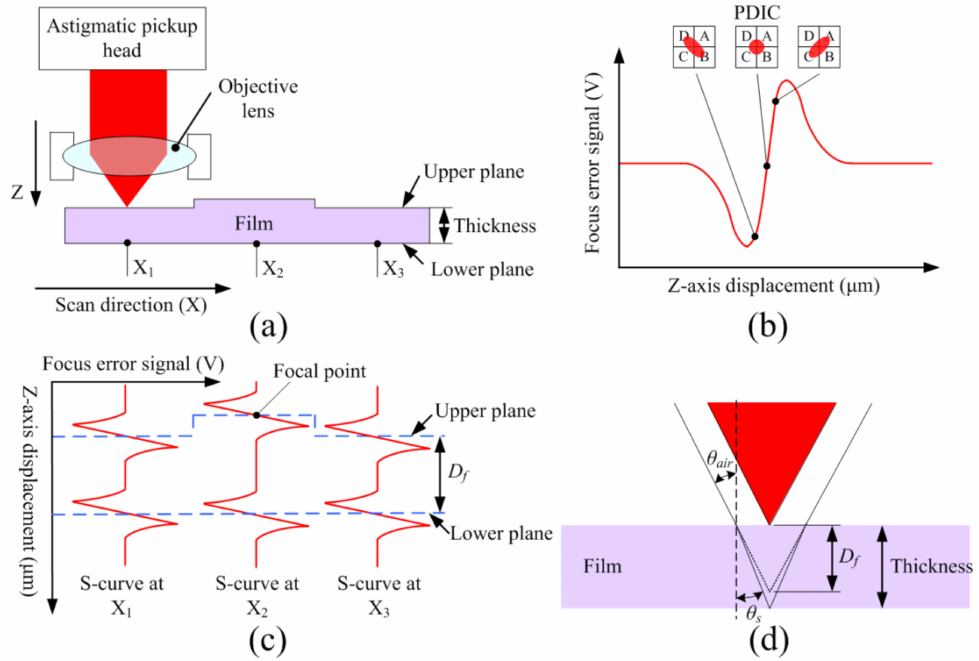
Figure 1. ( a ) Illustration of thickness measurement along the scanning direction. ( b ) Typical S- curve feature on a surface. ( c ) FES vs. z -axis displacement curves at corresponding positions in ( a ). ( d ) Illustration of refraction